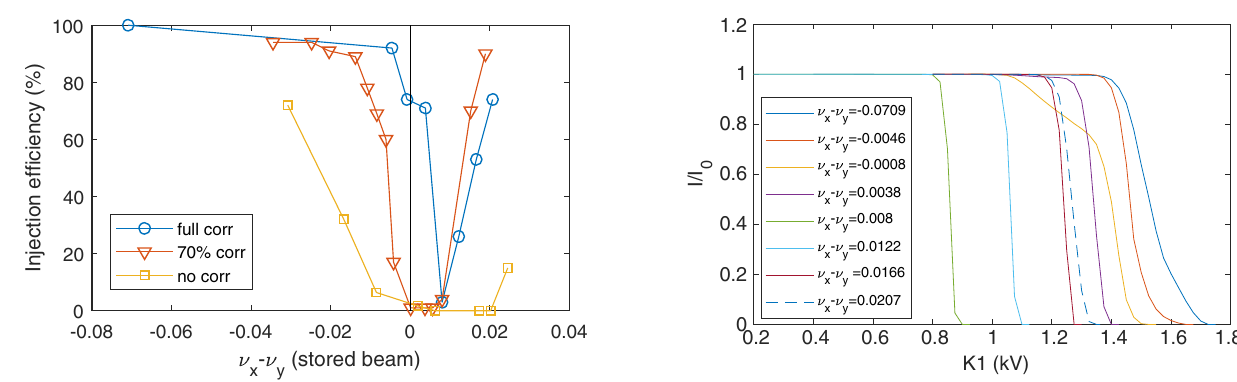
FIG. 1. Injection efficiency vs tune separation at three levels of linear difference resonance strengths.